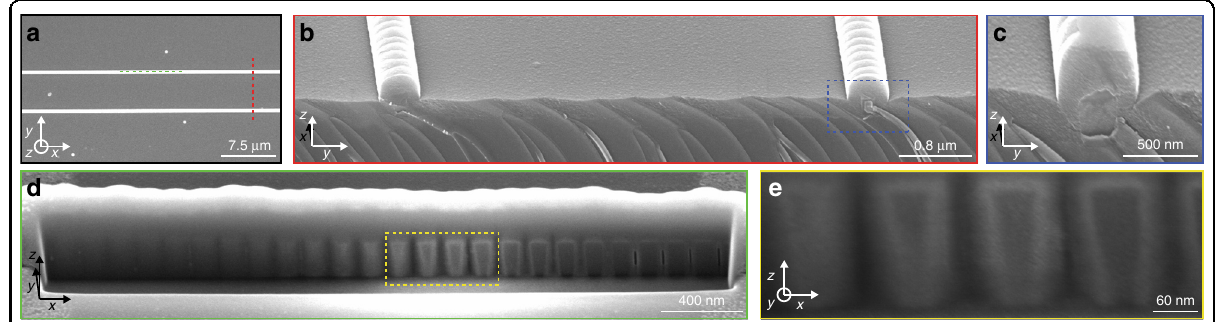
Fig. 2 Fabricated HCG waveguides. a Scanning electron microscopy (SEM) image of the fabricated HCG waveguide from the top. b SEM tilt view of a cleaved waveguide facet, indicated by the red dashed line in ( a ). c SEM close-up image of a grating element indicated by the blue dashed region in ( b ). d SEM image of a cross-section cut by focused ion beam milling through the grating, indicated by the green dashed line in ( a ). e SEM close-up image of four grating elements, indicated by the yellow dashed region in ( d